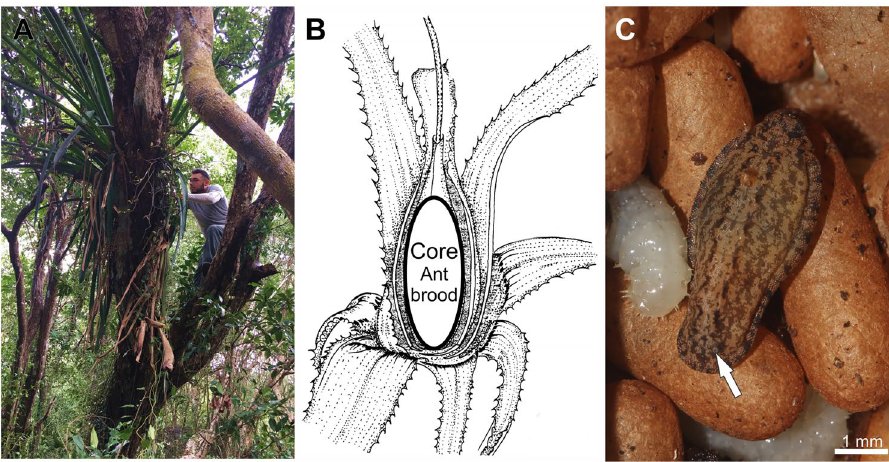
Figure 1. Pseudonymphidia agave caterpillar and the ant-plant system. ( A ) Habitat of Aechmea bracteata (collector: F.H. Rocha). ( B ) Ant nesting site in the bromeliad (modified from 41 ). ( C ) Mature larva of P. agave among the ant brood; the arrow indicates the opening of a tentacle nectary organ on the A8 abdominal segment. Photos: ( A ) G. Pérez-Lachaud; ( C ) F. H.